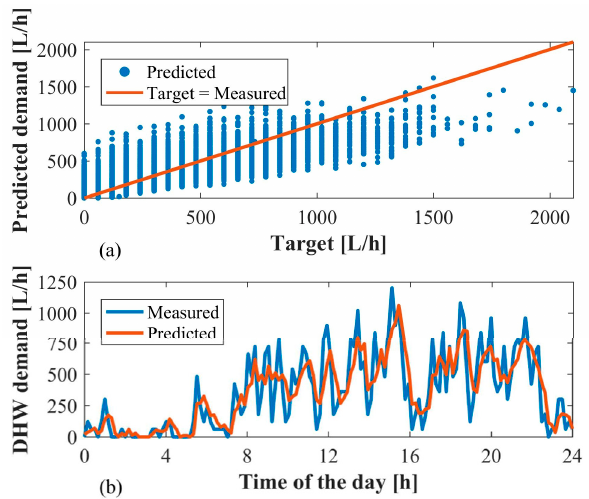
Figure 4. ( a ) Distribution of the predictions made and ( b ) daily consumption profile for a selected day with the RNN and RF by separating noise from demand signal.